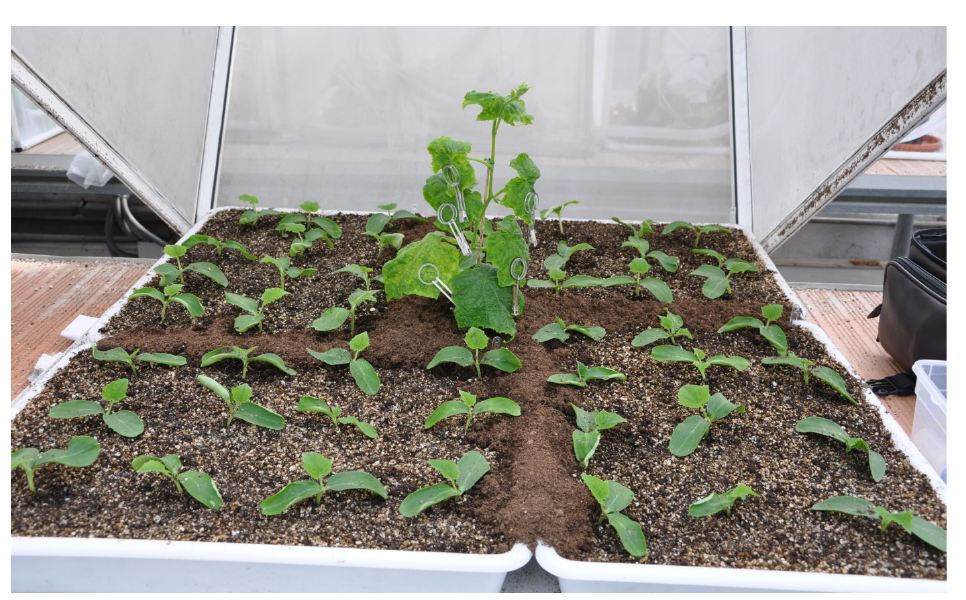
Figure 7. Spatial disposition of an arena, displaying the central virus source surrounded by the 48 test plants at a 1-true leaf